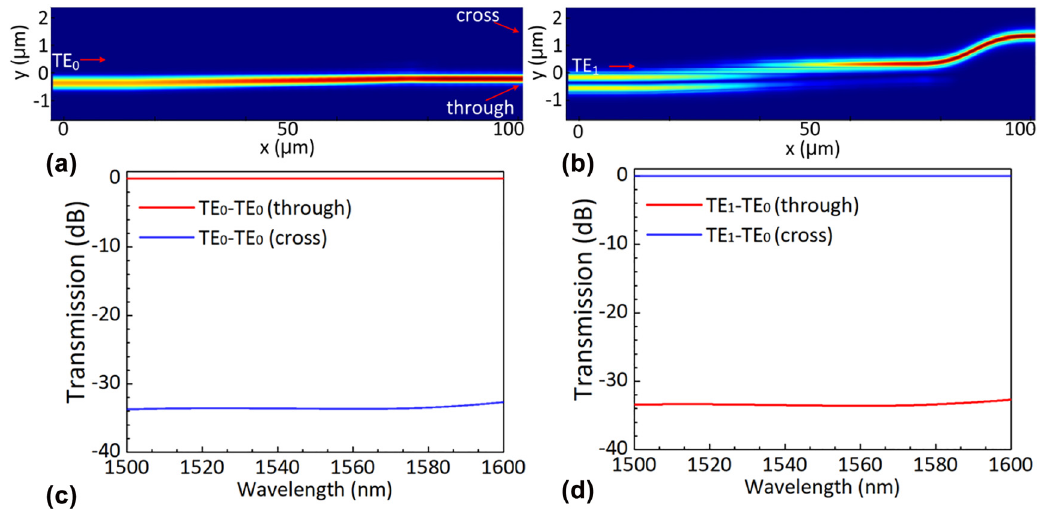
(a) and TE (b) modes in region R 0 1